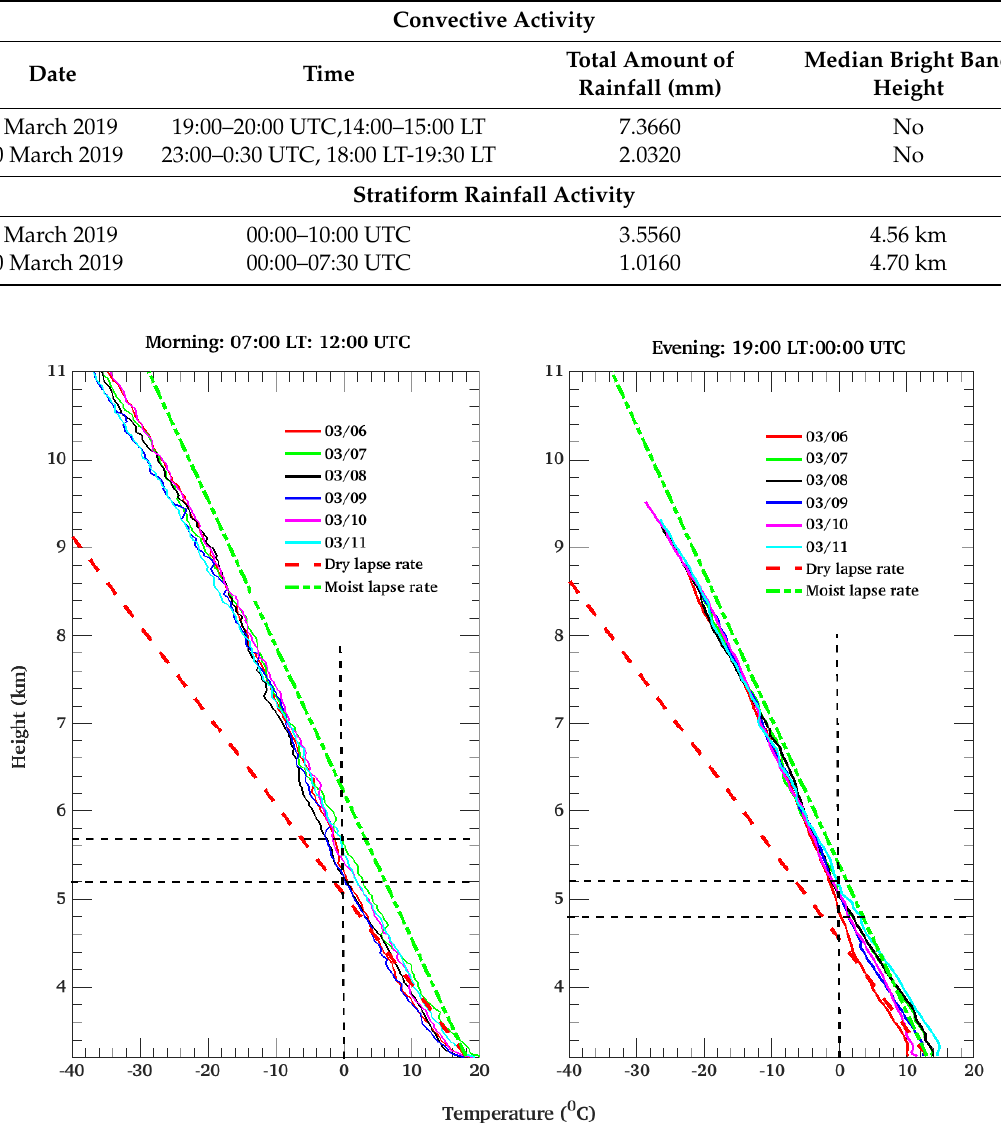
Figure 10. Vertical profiles of radar reflectivity (Ze) during the wet spells (6 March to 11 March 2019) from vertical profile of rain radar (VPRR). 4.2. Convective and Stratiform Rainfall Activity To investigate the microphysical and dynamical behavior during the convective and stratiform rainfall events, two convective and two stratiform precipitation events (CPEs and SPEs) are defined